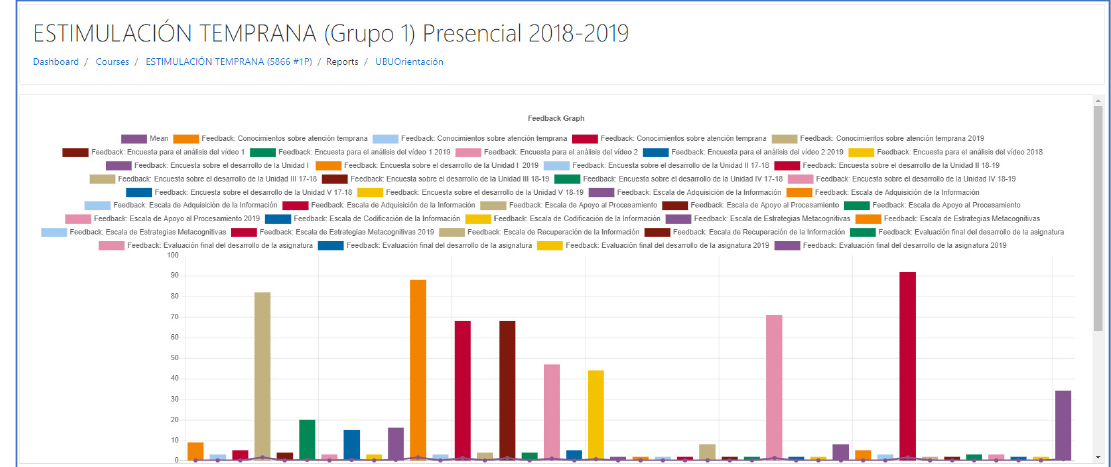
Figure 6. Bar graph of student participation in teacher feedback on different activities.